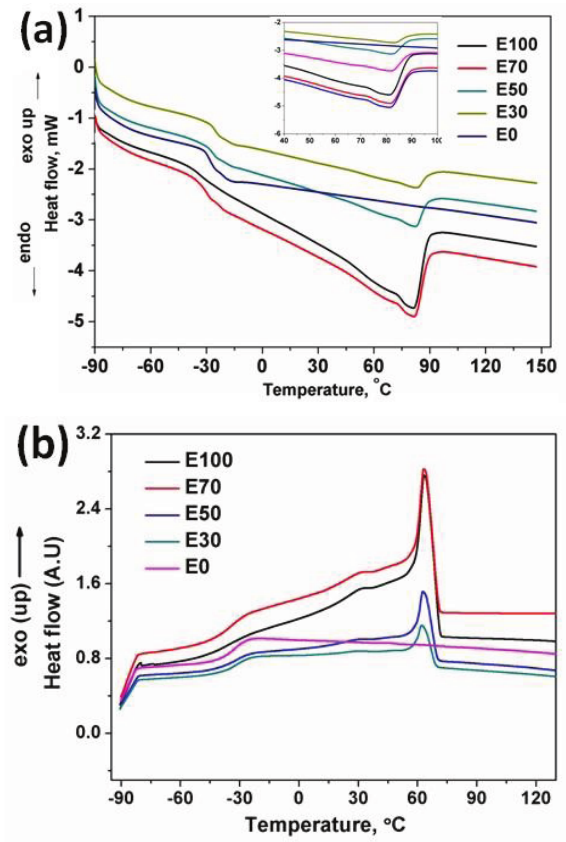
Figure 3: DSC profile: (a) DSC second heating curves and (b) DSC cooling curves.